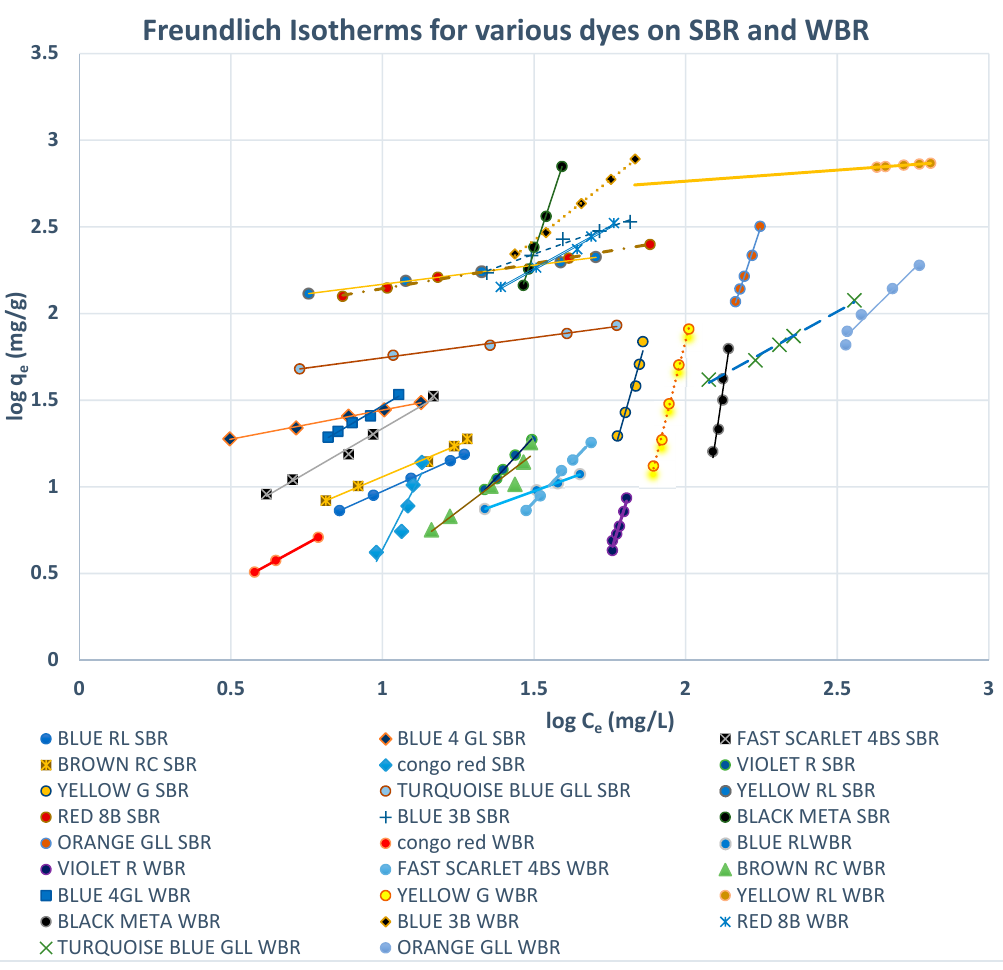
Figure 12. Freundlich isotherms for various dyes on SBR and WBR.